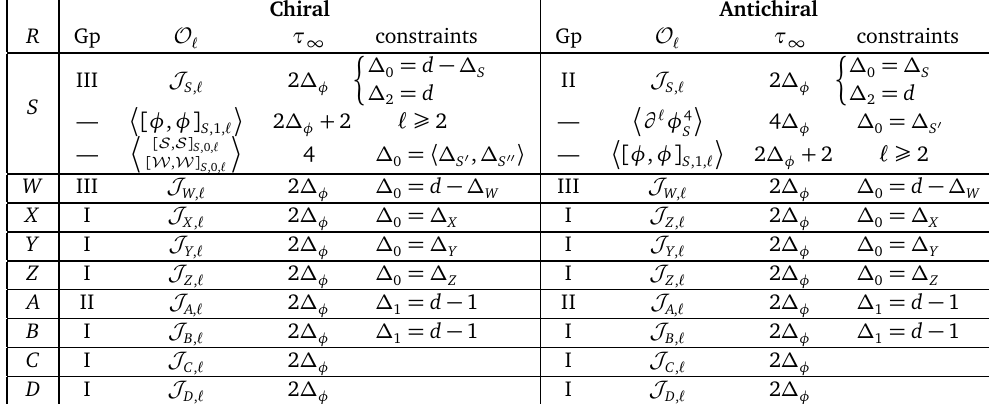
Table 2: Twist families in the large- n expansion. We give a couple of subleading twist families in the singlet case, and the leading family in the other irreps. We denote degenerate operators by 〈 · 〉